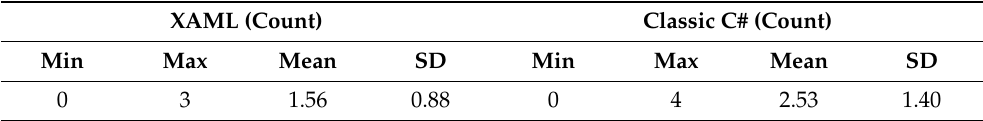
Table 1. A summary table on the number of incorrect answers (possible max: 10, possible min: 0) regarding the XAML and classic C# code ( n = 36).